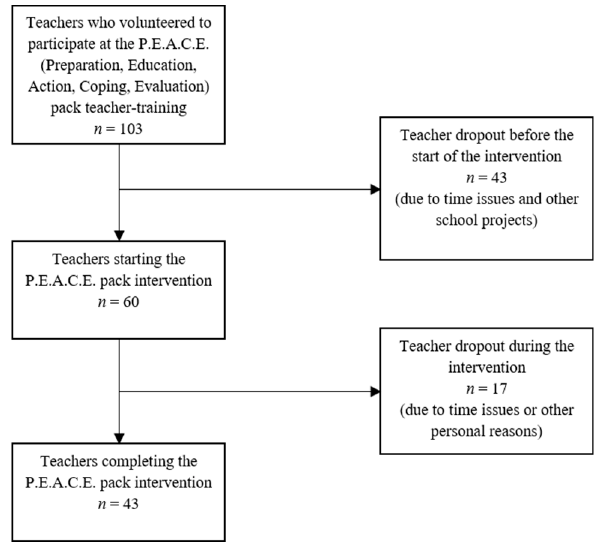
Figure 1. Flow diagram of the recruitment and selection of teachers.